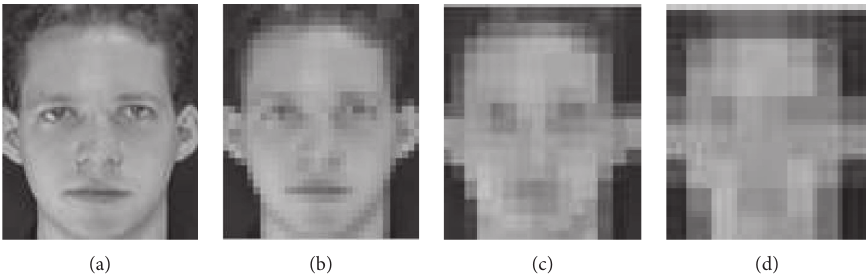
Figure 6: Different resolution images for one individual. (a) 64 × 64. (b) 32 × 32. (c) 16 × 16. (d) 8 × 8. Table 2: Face recognition results under different resolutions.